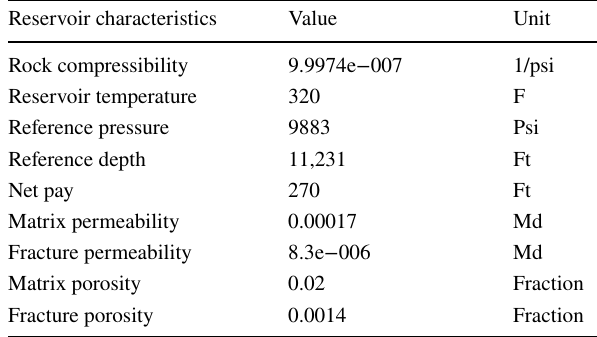
Table 11 Reservoir characteristics of all